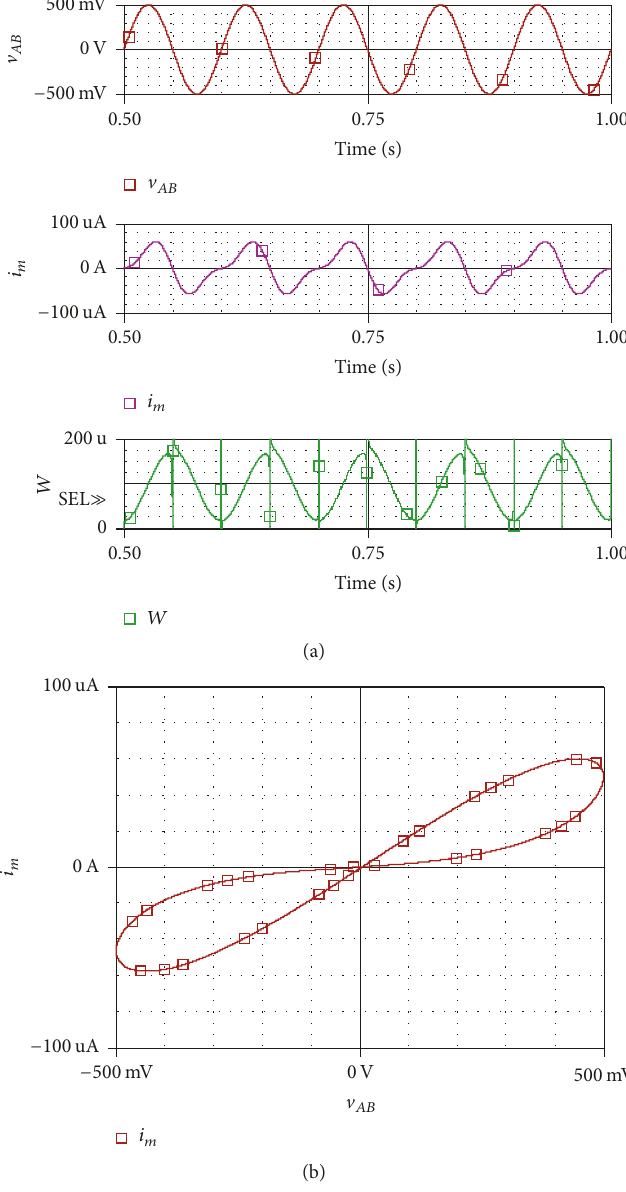
Figure 2: PSpice simulation results obtained with the incremental type memristor. (a) Time waveforms of the input voltage V 𝐴𝐵 , the input current 𝑖 𝑚 , and the memductance W ; (b) hysteresis loops in V - 𝑖 plane operating at